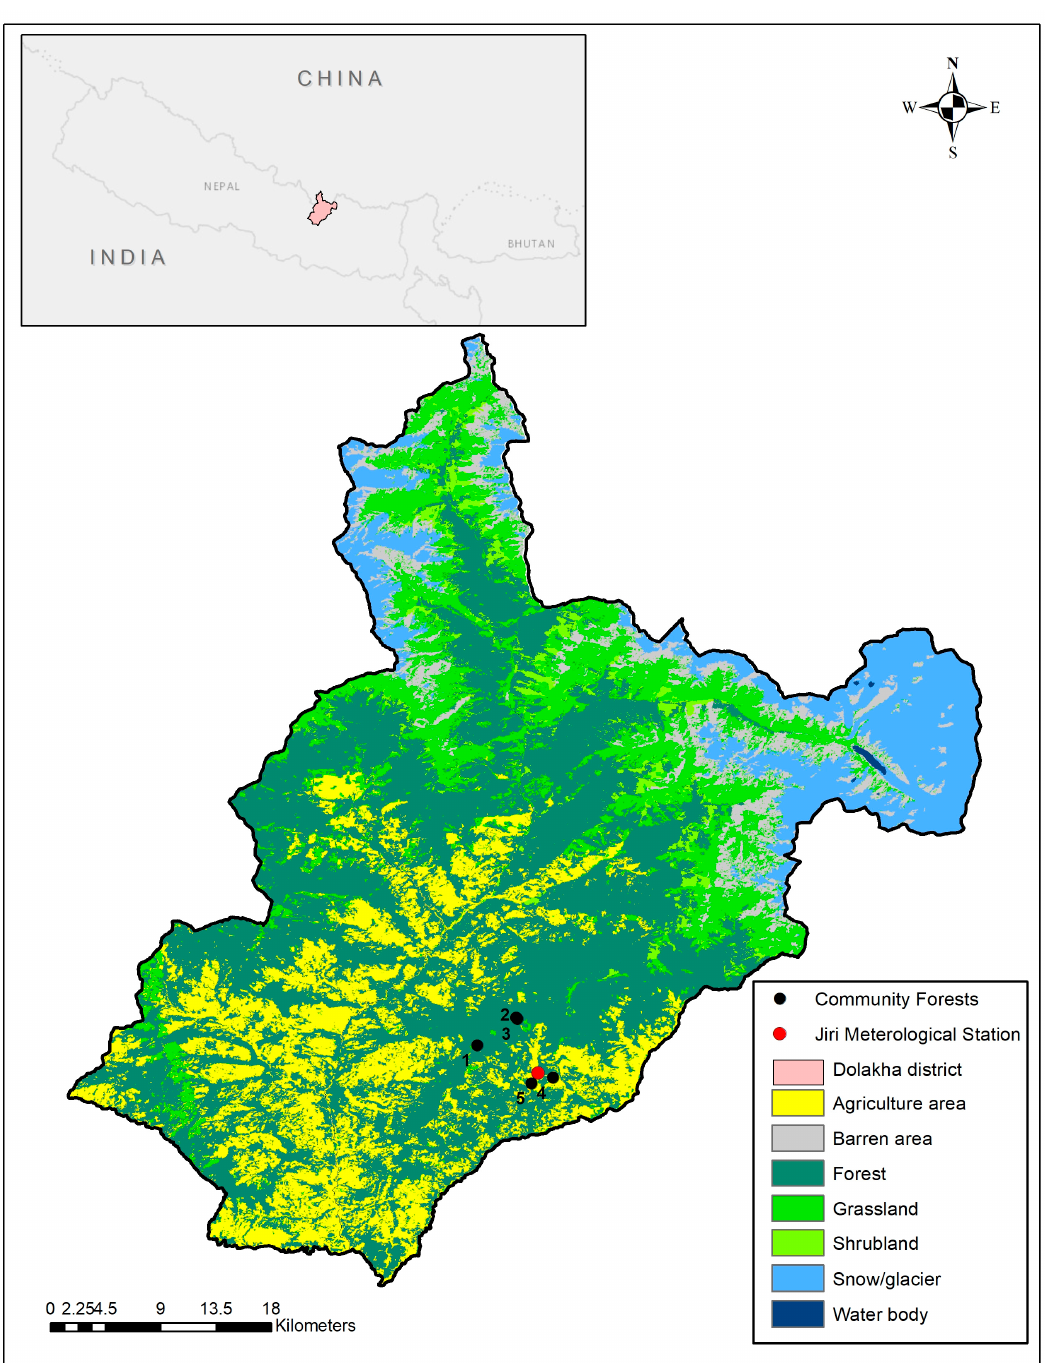
Figure 1. Map showing the location and outline of the study area Jiri, Nepal. The red-filled circle shows the location of the Jiri meteorological station (27.6304 E, 86.2321 N; 2003 m). Black filled circles indicate the location of the fi ve community forests (CFs) from where samples were collected, (1) Hanumante Community Forest (CF), (2) Bhatekhola CF, (3) Kalobhir CF, (4) Jireshwori CF, and (5) Debithan Kimane CF.